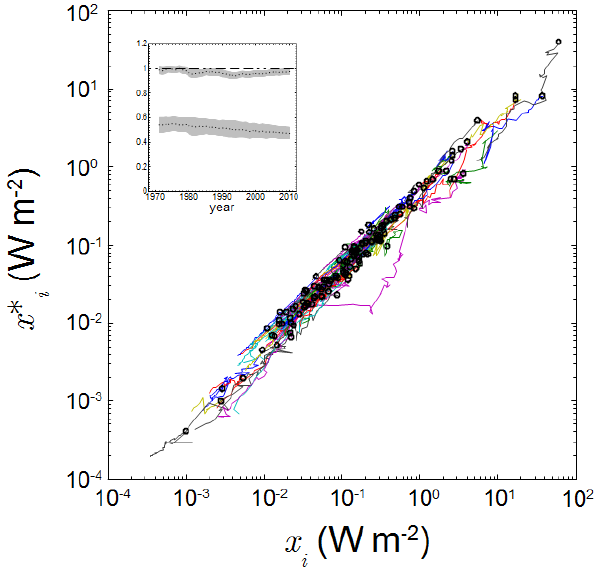
Figure 2. The relationship between country-specific primary en- ergy use, x i , and final energy use, x ∗ for the period 1971–2010. i Individual countries are marked with different colours, N = 140. The data for all countries for 2010 are marked separately (o). All country-specific energy data are normalised using the surface area of the country. The surface area is an imperfect proxy for the space occupied by each country if the global system is filling a three- dimensional volume. In the absence of data, we assume that the magnitude of the vertical dimension is constant across all 140 coun- tries. Note that the higher per unit area energy consumers have per unit area energy flows that are a significant proportion of the so- lar constant. The inset figure shows both the exponential scaling coefficient estimated from the annual relationship between x i and x ∗ (values near 1) along with the primary-to-final energy efficiency i x ∗ /x i plotted for each year 1970 to 2010. The bands represent 5th to i 95th uncertainty range for the estimates. See text for data sources and